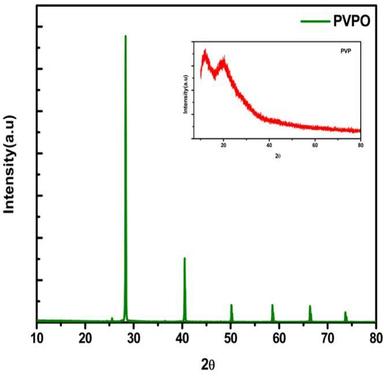
XRD of PVPO and PVP in insat.